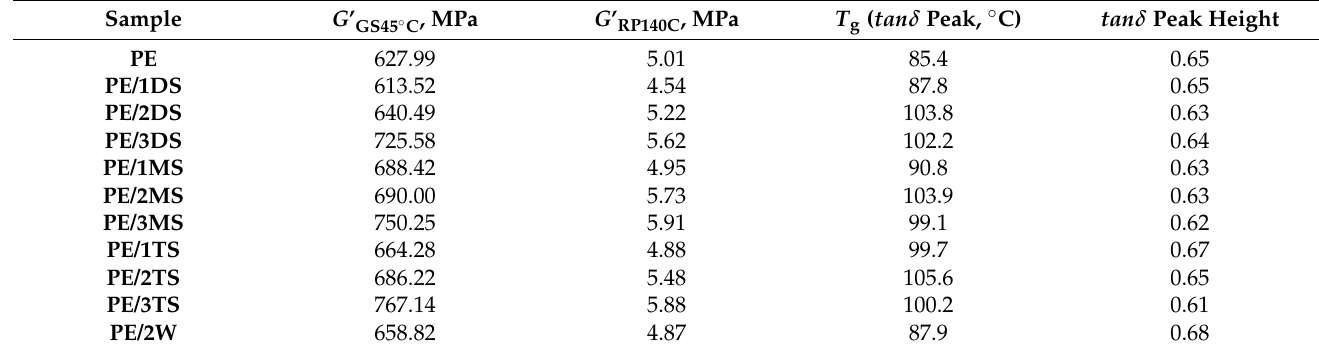
Table 5. DMA results of plain epoxy and corresponding